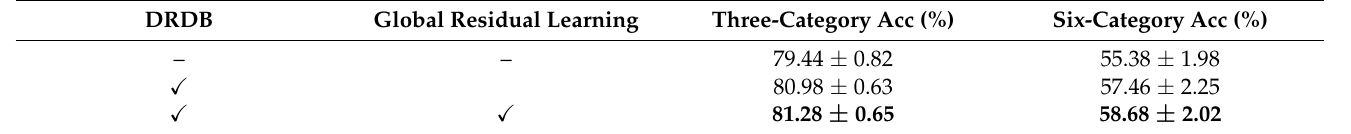
Table 9. Results of Feature Concatenation or Feature Adding in PCCAF.